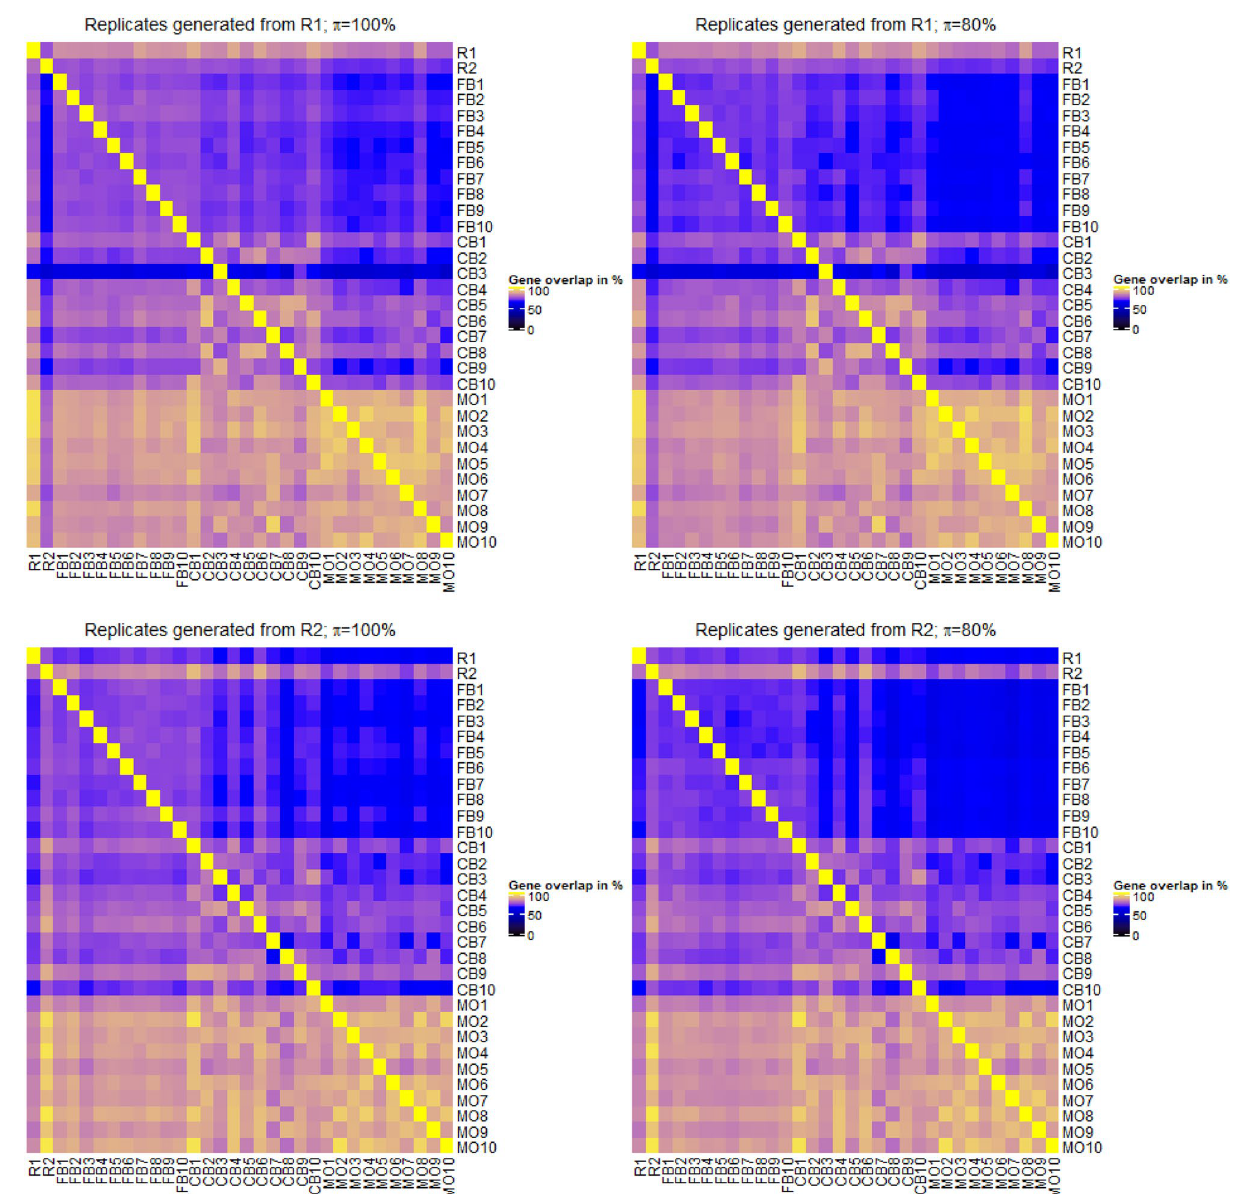
Figure 5. Heatmaps reflecting the overlap of selected differentially expressed genes from true experimental replicates R1 and R2 as well as from the artificial replicates with the three different approaches. Again, heatmaps are shown when artificial replicates were generated from R1 (top) or R2 (bottom) and with different values π for the FB apprach. Overlap is given in percent of genes detected in a comparison analysis (column) with respect to an reference analysis (row). Exemplarily, the interpretation for the plot top left is as follows. Replicates were generated from the data of R1 with the purpose of obtaining similar results as from R2, which is shown in the second line. Here, FB and CB results show a stronger overlap with R2 than results from the MO strategy. Heatmaps were drawn using the R-package ‘ComplexHeatmap’ (version 2.6.2., www. bioco nduct or.